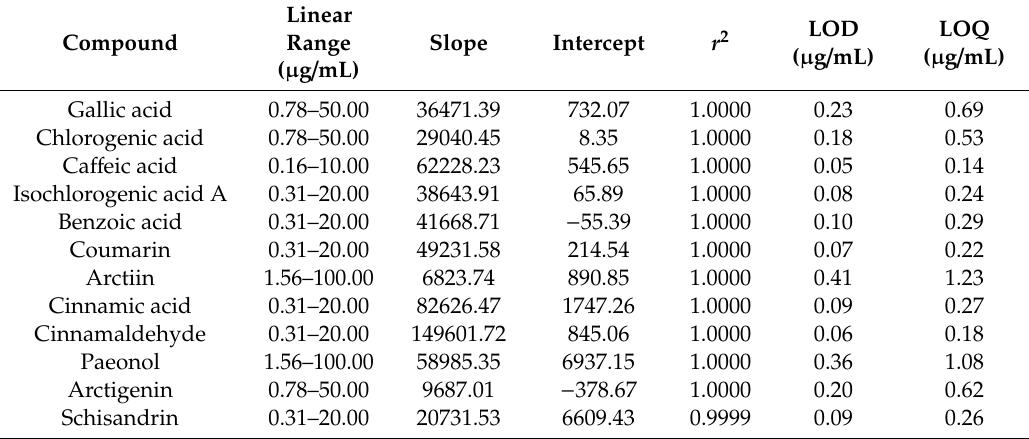
Table 2. Linear range, calibration curve, r 2 , limits of detections (LODs), and limits of quantification (LOQs) for marker compounds ( n = 3).